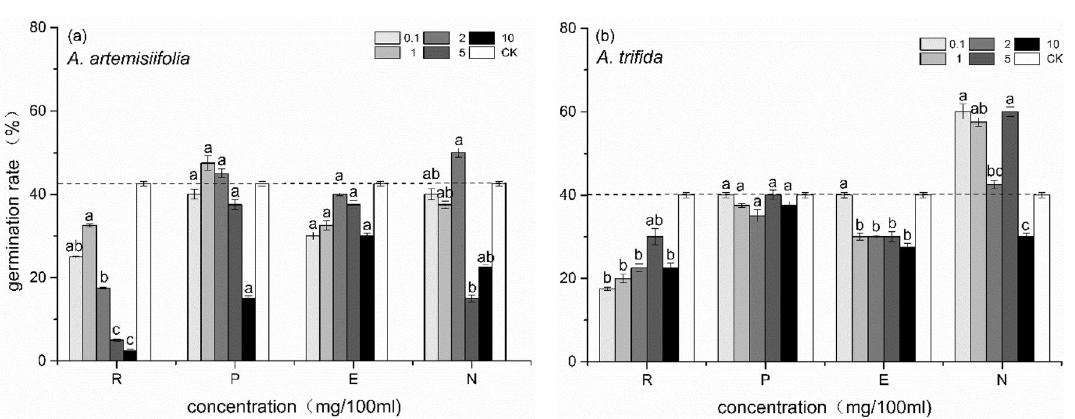
Figure 2. Germination potential of A. artemisiifolia and A. trifida on their own seeds. Different capital letters indicate significant difference in germination potential between concentration treatments ( p < 0.05). The units of germination potential are g 100 mL.